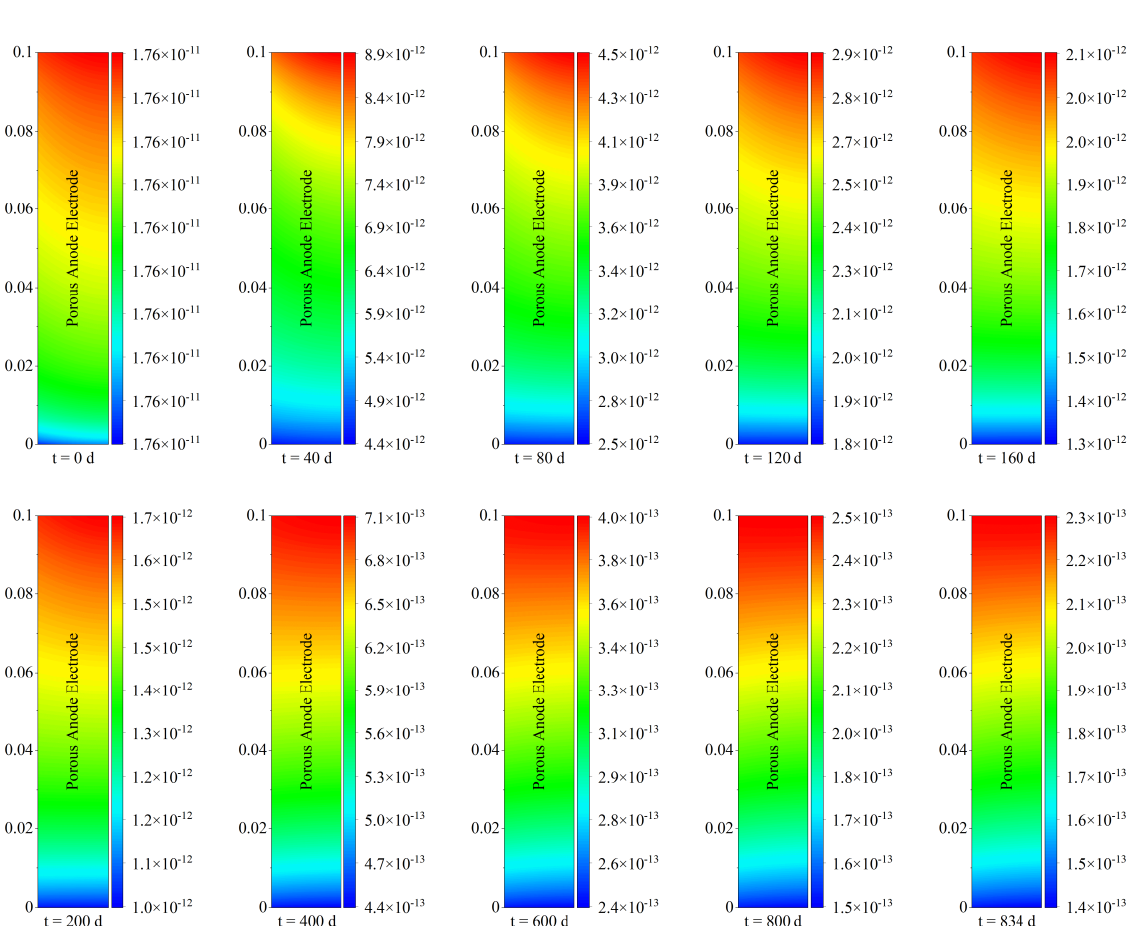
Figure 8. The variation in porous anode electrode permeability over the operating time during 20,000 h of steady − state operation.